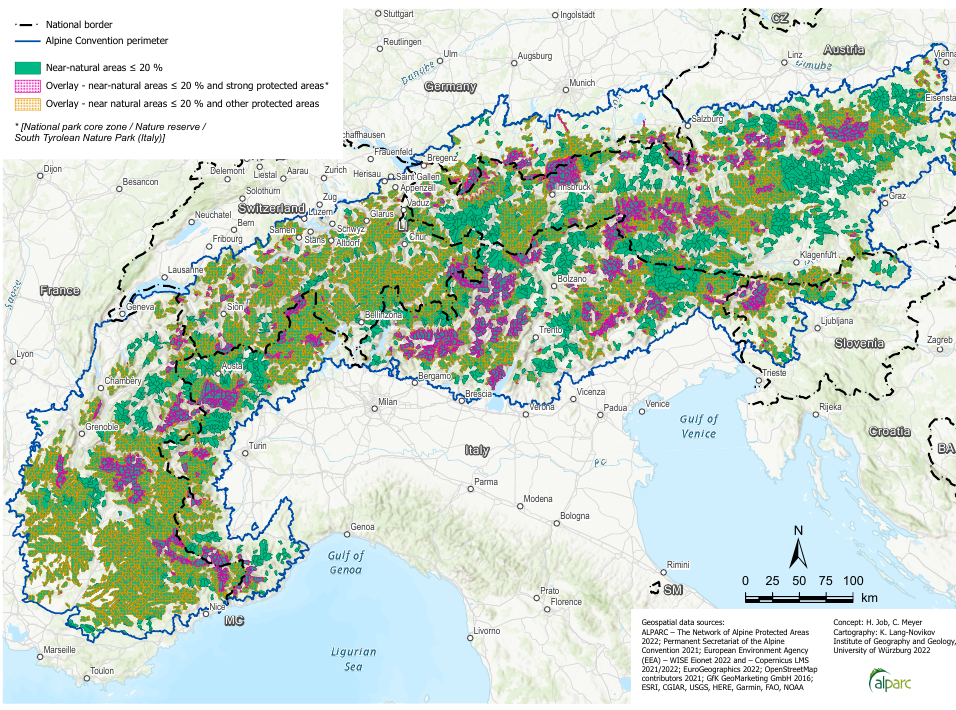
Figure 5. Overlay analysis of near-natural areas ( ≤ 20%) and alpine protected areas (source: authors’ figure, data provided by